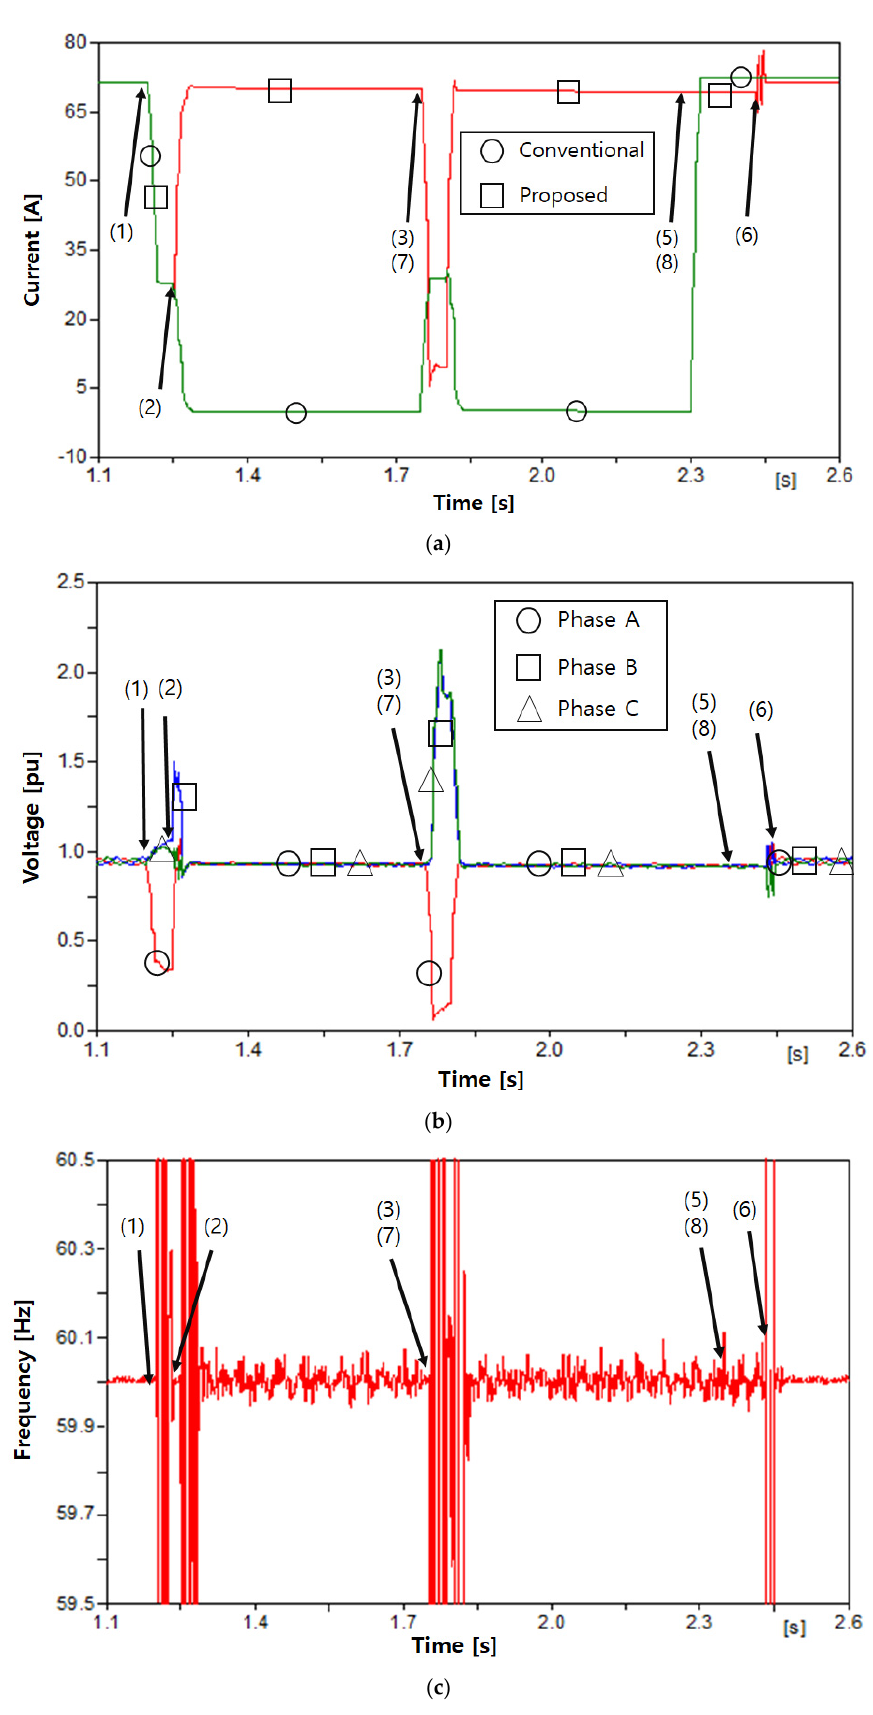
Figure 11. Simulation results of Case 4: ( a ) current flowing to Load 2; ( b ) voltage at Bus 3; ( c ) frequency at Bus 3.